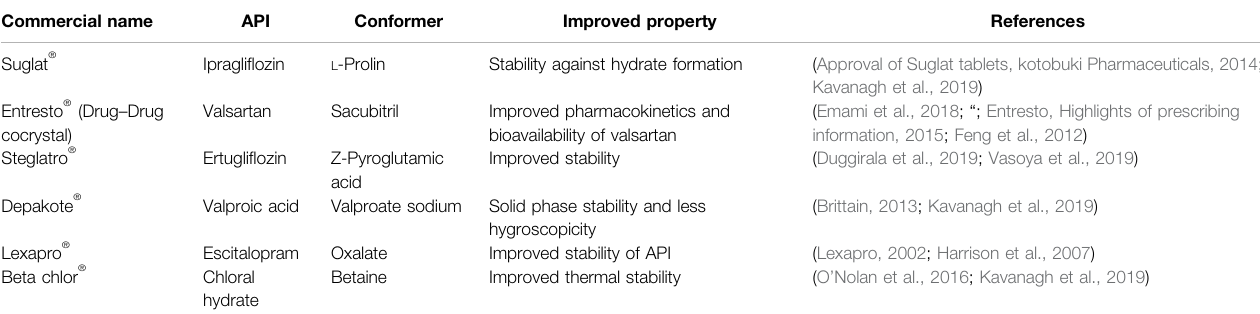
TABLE 1 | Commercially available pharmaceutical cocrystals.